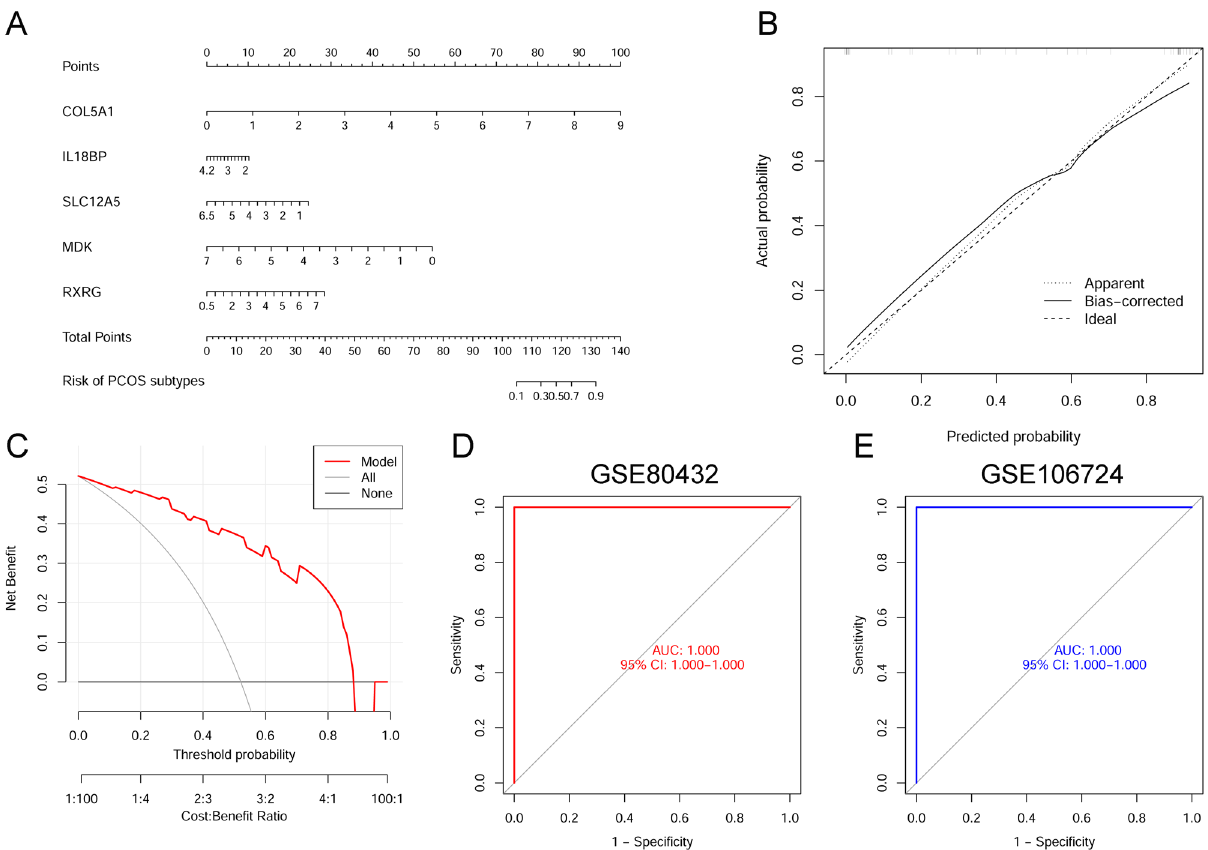
Figure 9. Verification of the 5-gene-based SVM model. ( A ) Construction of a nomogram for predicting the risk of PCOS clusters based on the 5-gene-based SVM model. ( B , C ) The prediction power of Nomogram was evaluated by the construction of calibration curve ( B ) and DCA ( C ). ( D , E ) ROC analysis of the 5-gene-based SVM model based on fivefold cross-validation in GSE80432 ( D ) and GSE106724 ( E )